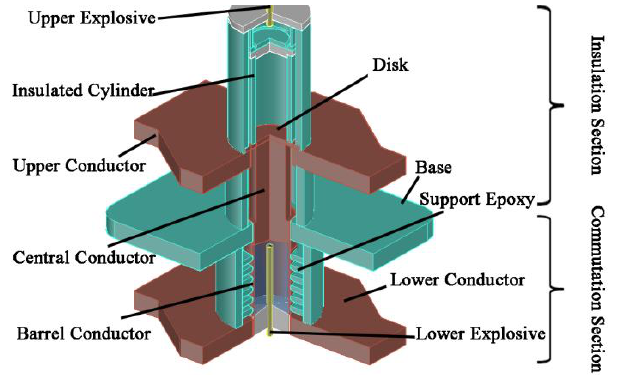
Figure 1. Structure of the integrated type pyro-breaker. Table 1. Resistance and heat flow of the electrical contacts and the barrel